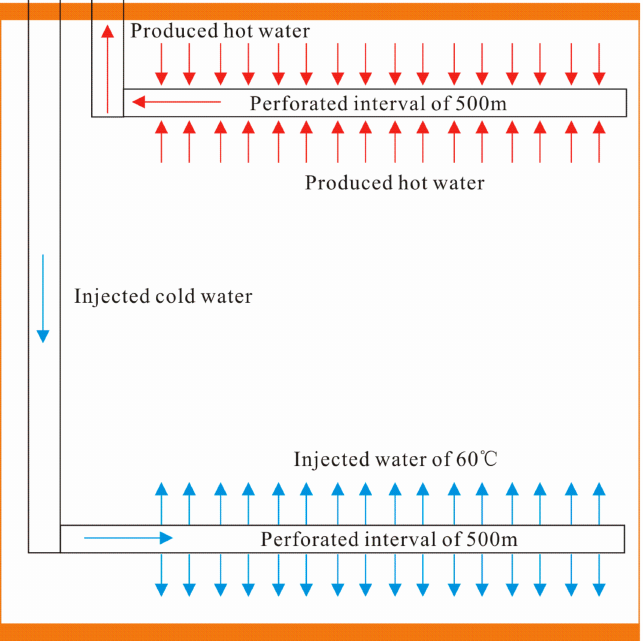
Figure 1. Schematic of a conceptual horizontal well enhanced geothermal system in hot